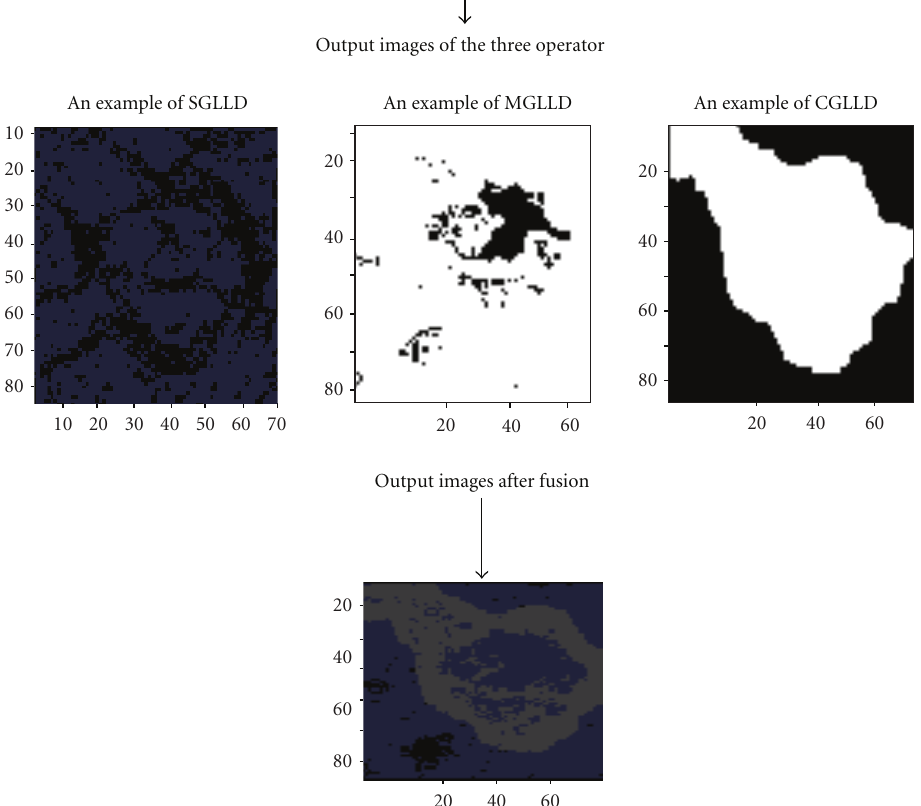
Figure 5: The image results after the application of the three operator and their